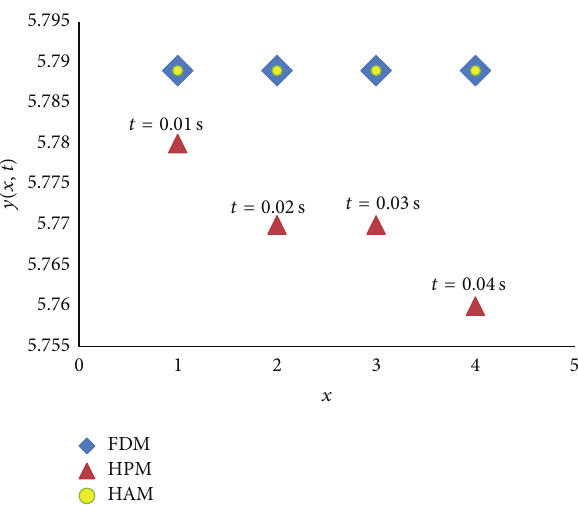
Figure2:ThecomparisonofHPM,HAM,andFDMforthesolution 𝑦(𝑥,𝑡) for different values of 0 ≤ 𝑥 ≥ 4 and 0 ≤ 𝑡 ≥ 0.04 ; ℏ = 0.001 .